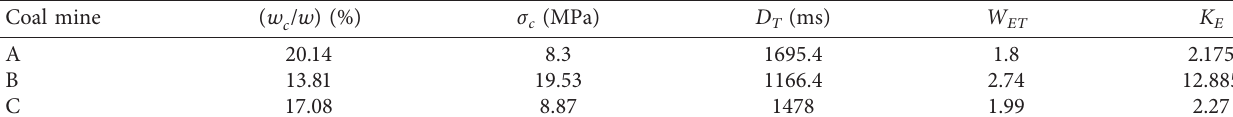
Table 4: Fracture strain energy and burst tendency index.